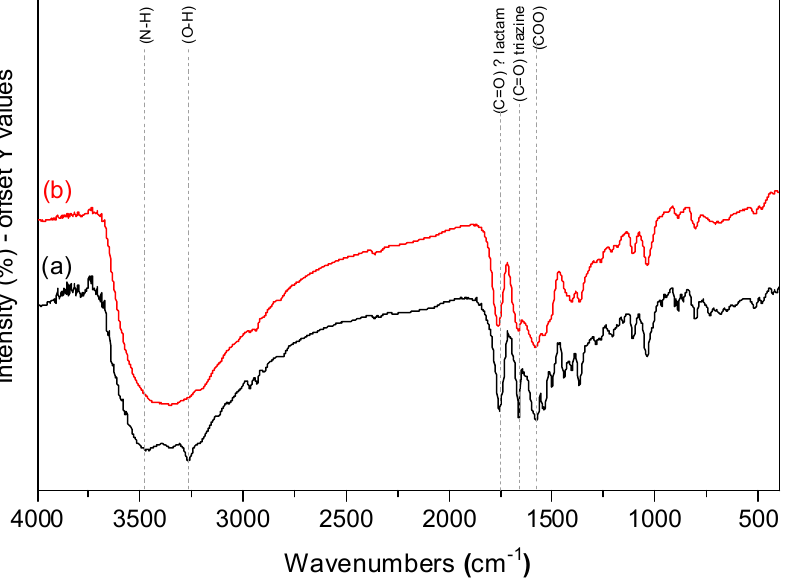
Figure 6. FTIR spectra of fresh (a) CaHS (black) and (b) CaHS-D obtained after thermal treatment at 150 °C for 2 h (red).